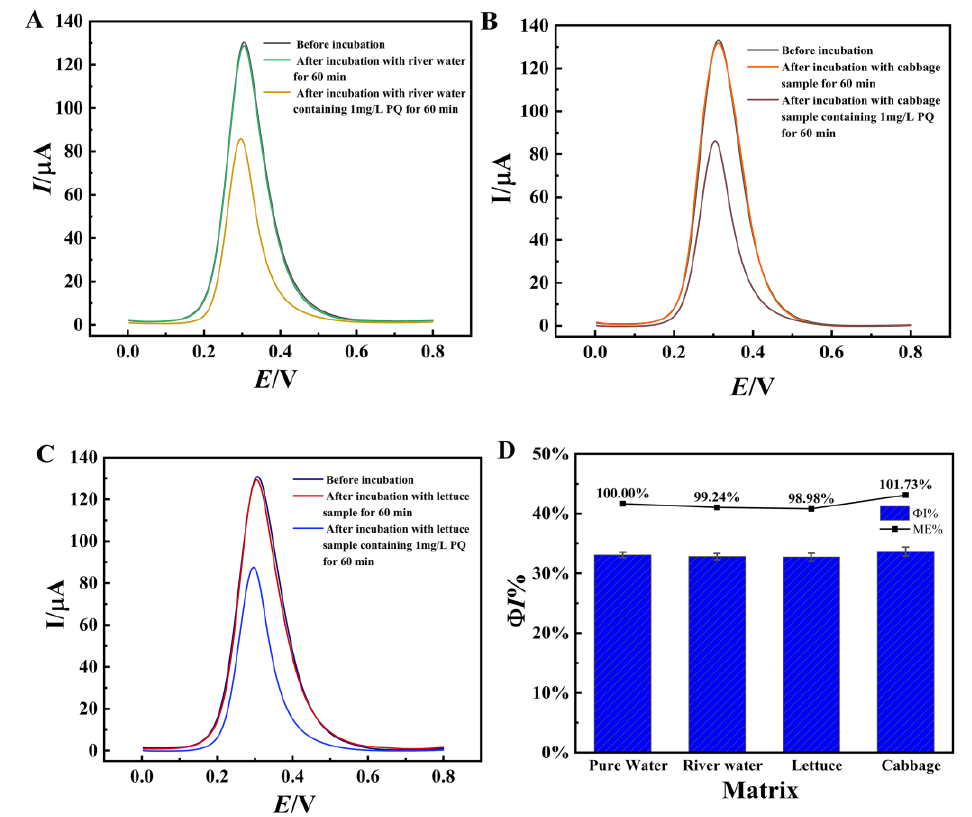
Figure 12. DPV curves of the aptasensors before and after incubation with different actual samples. ( A ) river water sample, ( B ) Cabbage sample, ( C ) lettuce sample and ( D ) Ф I % and ME values of the sensors after incubation with actual samples containing 1 mg/L PQ. Error bars were obtained as the standard deviation of triple measurements ( n = 3).